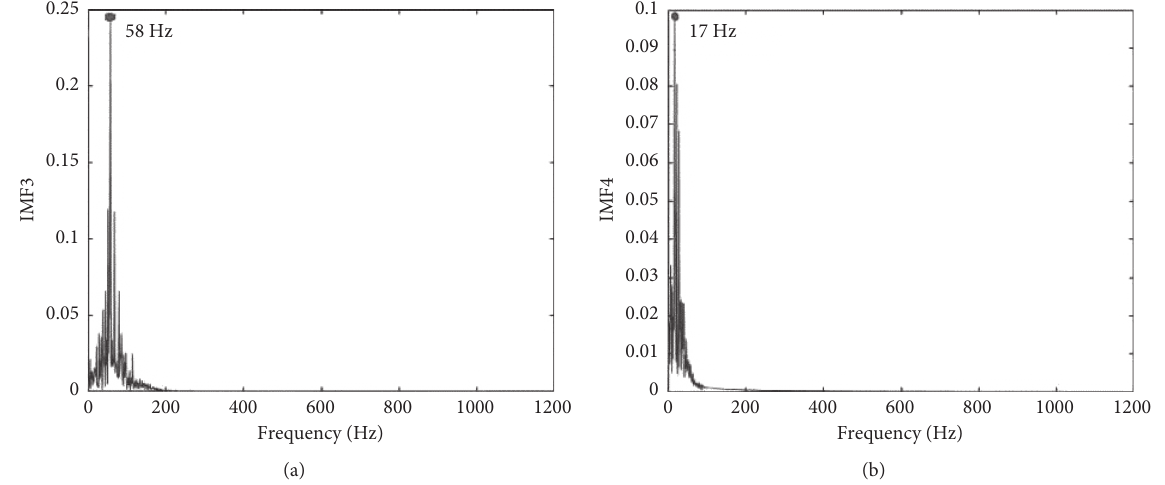
Figure 12: (a) Amplitude-frequency of IMF3. (b) Amplitude-frequency of